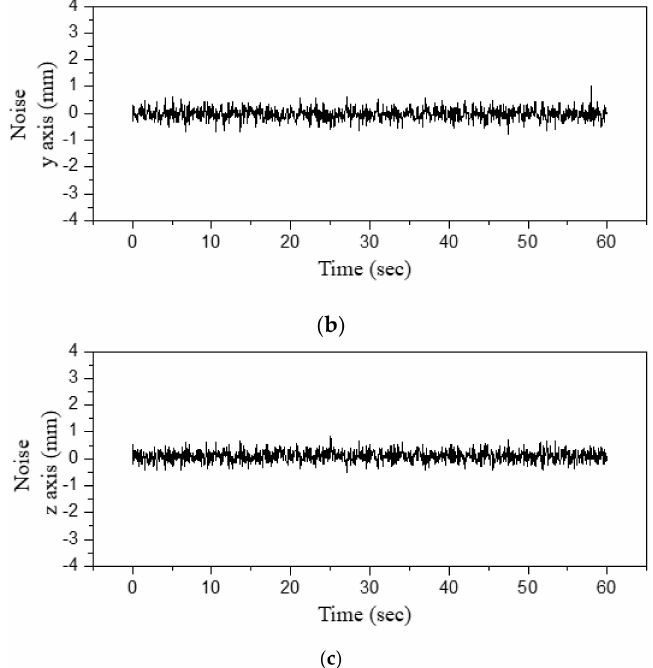
Figure 5. Data of 3-mm 1-Hz segment after coordinate transformation. ( a ) X -axis reflects the real displacement of the sliding block of the 3-mm, 1-Hz segment; ( b ) shows the data captured on the Y -axis; ( c ) shows the data captured on the Z -axis.